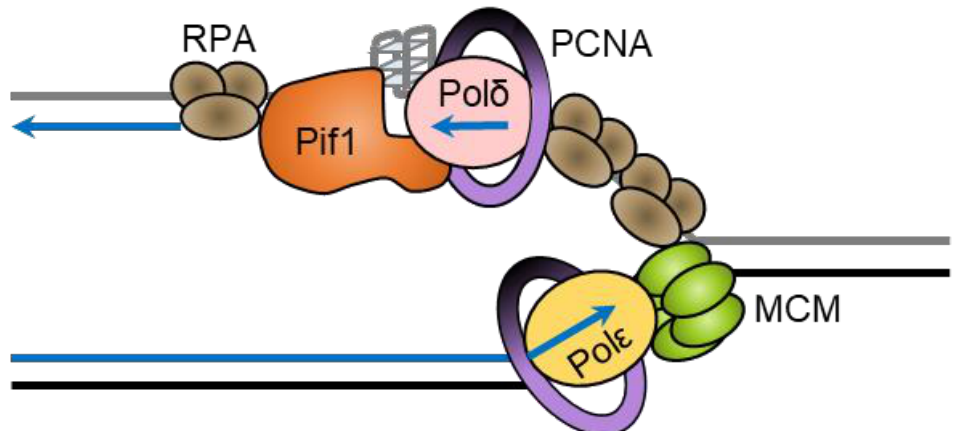
Figure 3. ScPif1 stimulates replication through lagging-strand G-quadruplexes. The leading strand is synthesized by Pol ε (yellow) in complex with PCNA (purple) at the same time as duplex unwinding by CMG (green). RPA (brown) may not be able to prevent G4 structures from forming on the lagging strand, so Pif1 (orange) may unfold G4 structures so that Pol δ (pink) can synthesize the lagging strand in complex with PCNA. Since Polδ translocates 3′-to-5′ on the template and Pif1 translocates 5′-to-3′, Pif1 would approach the G4 structure from the opposite side to that of Polδ.